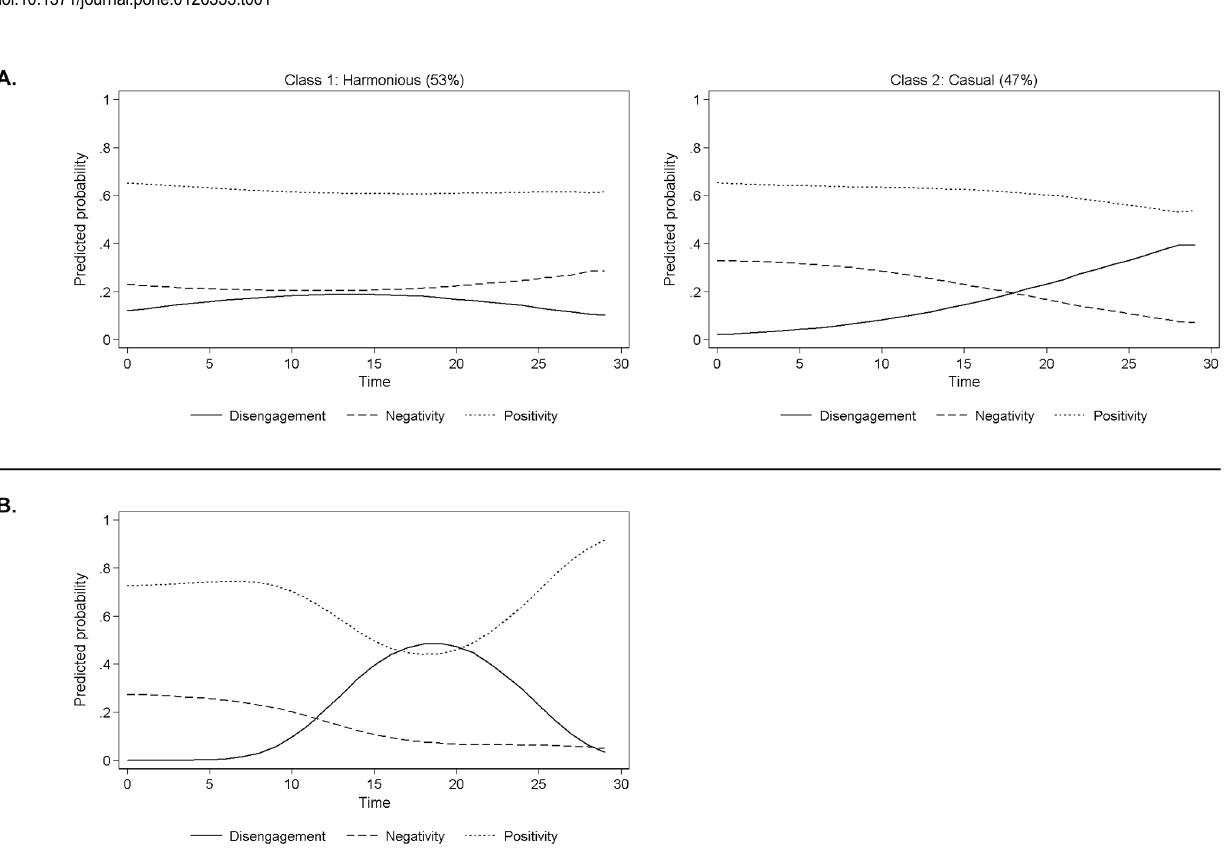
Fig 1. Average predicted probability of temporal behavioral sequences from the accepted 2-class model (A) and the third class from the rejected 3-class model (B) for younger